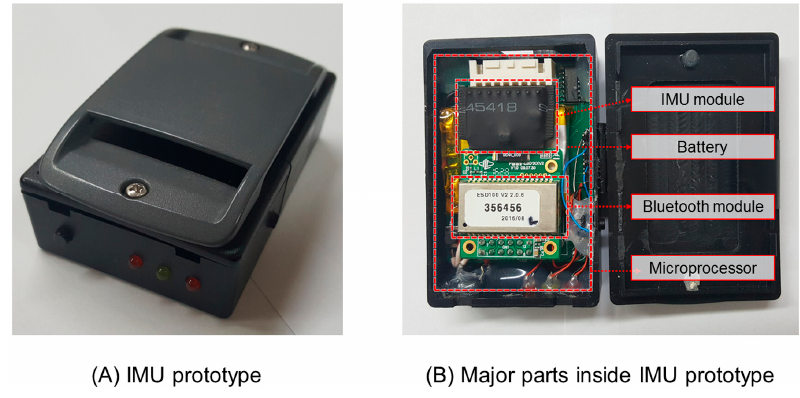
Figure 1. Inertial measurement unit (IMU) prototype.